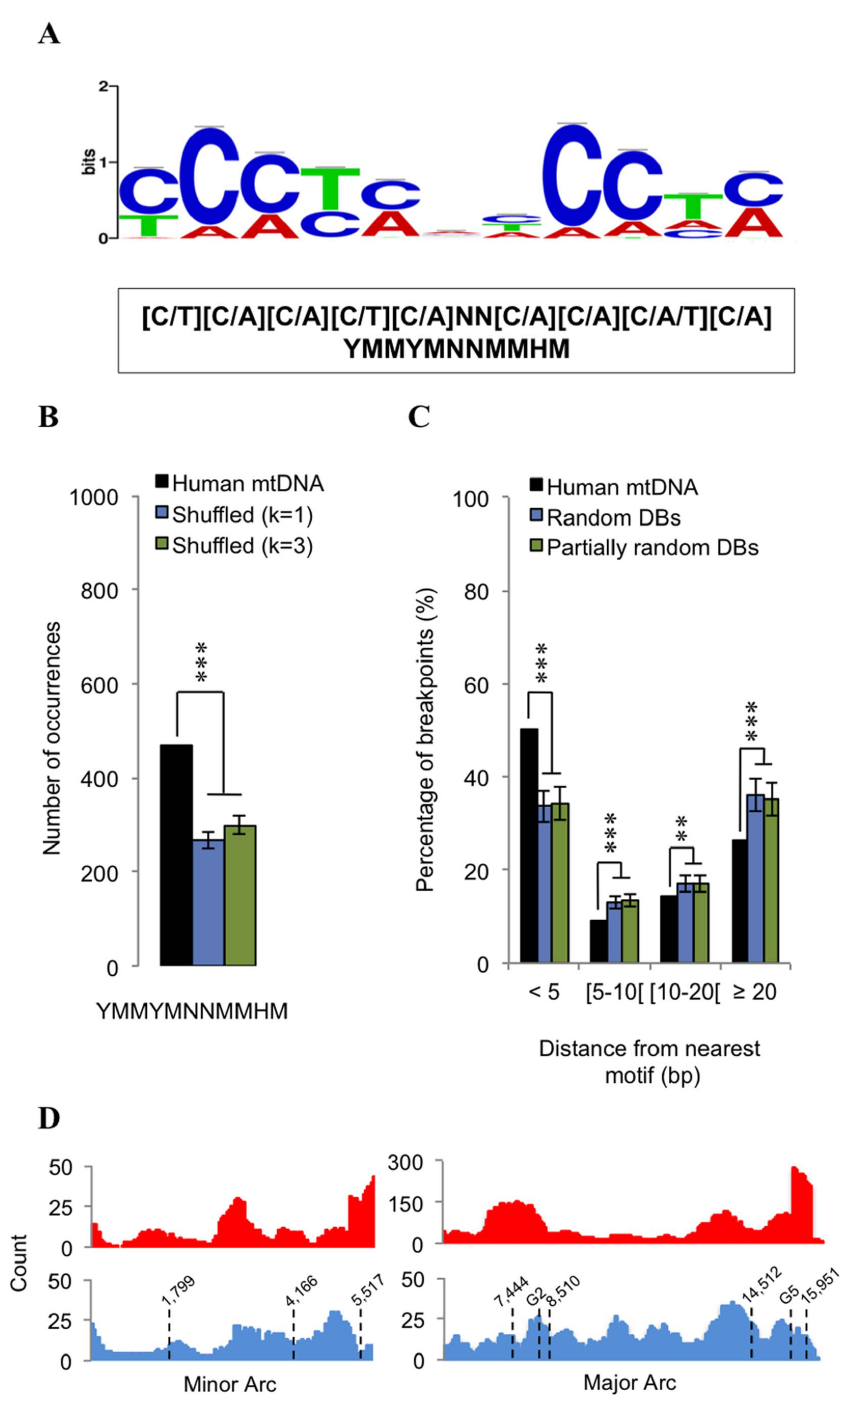
Figure 5. Search for over-represented motifs in the close vicinity of deletion breakpoints. (A) Sequence logo of the degenerate 11-mer motif over-represented in the close vicinity ( 6 15 bp) of the non-repeated breakpoint dataset. Representative logos were obtained from MEME and AlignACE (see Fig. S2), and compared both manually and using the STAMP tool. Degenerate nucleotides are as follows: Y=(C or T); M=(A or C); H=(A or T or C); N=(A or T or G or C). (B) The number of occurrences of the YMMYMNNMMHM motif in the human mtDNA (black bar) is compared with those obtained from randomly shuffled genomes preserving k-tuples of 1 and 3 (respectively blue and green bars). (C) Percentage of breakpoints in terms of distance (bp) to the nearest YMMYMNNMMHM motif. Black bars represent the percentage values obtained for the human mtDNA, whereas blue and green bars respectively represent the values computed after randomization and partial randomization of deletion breakpoints. Error bars represent standard deviations. * p , 0.05; ** p , 0.01; *** p , 0.001. (D) Distribution profiles of breakpoints (red) and YMMYMNNMMHM motif (blue) along the minor arc (left) and major arc (right). Stippled lines indicate the positions of the previously identified highly bent regions as well as of the G2 and G5 motifs.